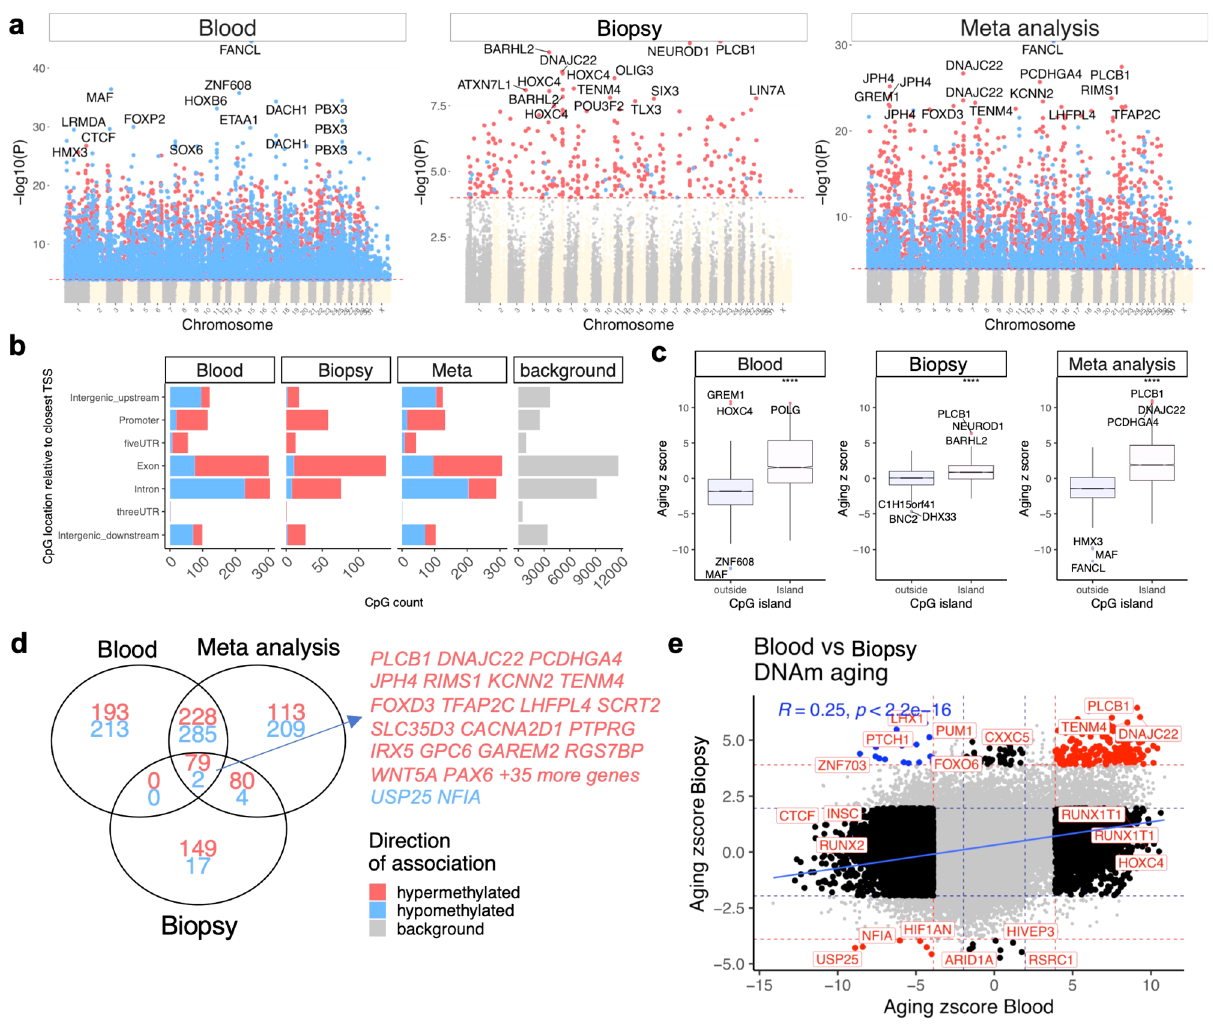
Fig. 3 Epigenome wide association study (EWAS) of chronological age in blood and skin of plains zebras. a Manhattan plots of the EWAS of chronological age. Since a genome assembly was not available for zebra, the coordinates are estimated based on the alignment of Mammalian array probes to EquCab3.0.100 (domestic horse) genome. The direction of associations with p < 10 − 4 (red dotted line) is highlighted by red (hypermethylated) and blue (hypomethylated) colors. The top 15 CpGs were labeled by the neighboring genes. b Location of top age-related CpGs in each tissue relative to the closest transcriptional start site. Top CpGs were selected at p < 10 − 4 and further fi ltering based on z-score of association with chronological age for up to 500 in a positive and negative direction. The number of selected CpGs: blood, 1000; biopsy, 331; meta-analysis, 1000. The gray color represents the location of 3,1836 mammalian BeadChip array probes mapped to EquCab3.0.100 genome. c Boxplot of z-scores from a correlation of age with CpG location (within or outside CpG islands). The median Z statistics are signi fi cantly different ( p < 10 − 4 ). d Venn diagram of the top age-related CpGs in blood and biopsy samples from plains zebras. e Sector plot of DNA methylation aging in plains zebra blood and biopsy tissues. Red dotted line: p < 10 − 4 ; blue dotted line: p > 0.05; Red dots: shared CpGs; black dots: tissue-speci fi c changes; blue dots: CpGs whose age correlation differs between blood and biopsy